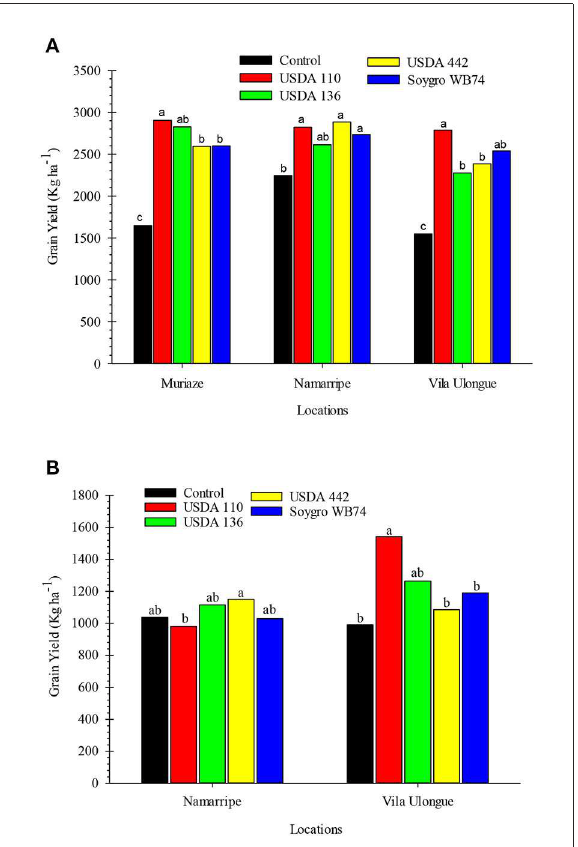
FIGURE3 Grain yield of soybean inoculated with various inoculant strains in 2018 (A) and 2019 (B) in Mozambique. Means within a location followed by the same letter are not significantly different at P < 0.05 according to